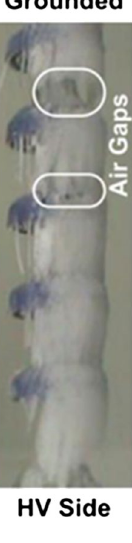
Figure 2. Surface performance of iced insulator strings.